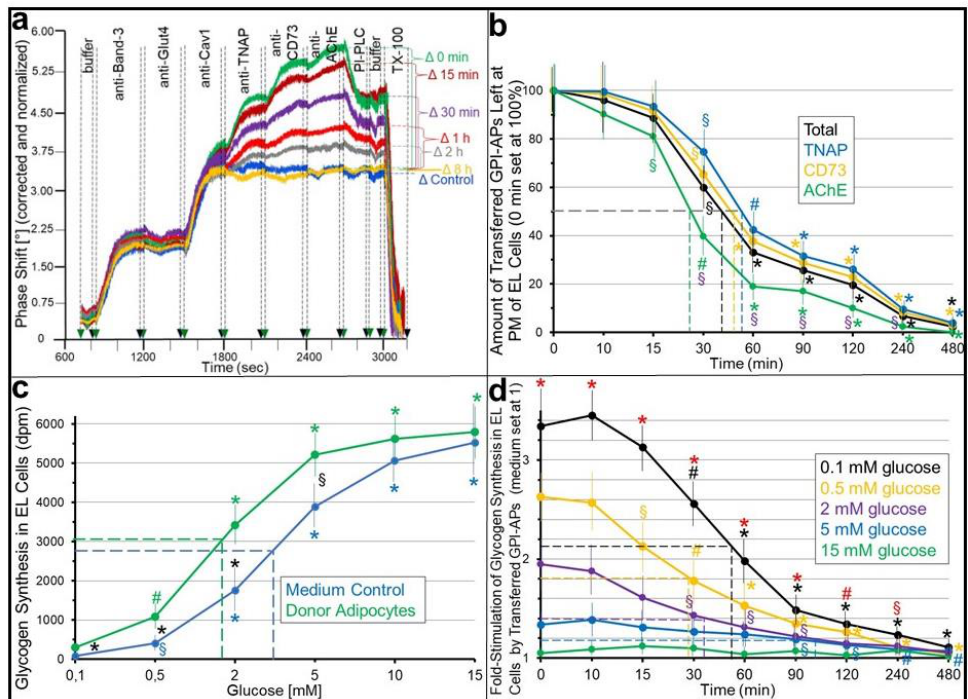
Figure 1. Parallel loss of transferred GPI-APs and of upregulated glycogen synthesis in acceptor ELCs. Transwell co-cultures were run with human adipocytes (of lipid-loading stage IV) as donor cells or only medium (Control) and GPI-deficient ELCs as acceptor cells in the insert and bottom wells, respectively, as described in Section 4. ( a ) After incubation (i) for transfer (1 week, 37 °C, absence of serum and BSA), the insert wells were removed. The bottom wells were rinsed once with medium and then subjected to incubation (ii) with medium for internalization (37 °C, absence of serum and BSA) for the periods indicated (Control for 8 h). Subsequently, PMs were prepared from the ELCs of the bottom wells, then coupled to chips by ionic/covalent capture and, finally, analyzed for the expression of membrane proteins by SAW sensing, as described in Section 4. Phase shifts induced by the sequential binding of antibodies against transmembrane proteins (800 – 1800 s) and then GPI-APs (1800 – 2700 s) and by the subsequent action of bacterial PI-PLC (2700 – 2900 s) and, finally, TX-100 (3000 – 3200 s) are shown, omitting the preceding capturing of the PMs (0 – 700 s; for details as well as methods of correction and normalization, see [29]). Phase shift Δ measured in response to the injection of the anti-TNAP, CD73 and AChE antibodies (1800 – 2700 s) as summation signals, indicated by the horizontal, hatched lines and brackets for each incubation period. ( b ) The experiment was repeated four to six times (distinct incubations for both [i] and [ii]). Relative amounts of total GPI-APs (black line, summation signals corresponding to panel a, 1800 – 2700 s) or individual GPI-APs (colored lines, single signals corresponding to panel a, 1800 – 2100, 2100 – 2400, 2400 – 2700 s) transferred from the adipocytes during the incubation (i) and left at PMs of ELCs after the various periods of incubation (ii) are given. Significant differences between start of internalization (100% GPI-APs left at PMs at 0 min of incubation [i]) and the various periods of second incubation (0 – 480 min) for both total (black symbols) and individual GPI-APs (colored symbols), as well as between total GPI-APs and AChE, for each period of incubation (ii) (turquois symbols) are indicated. ( c , d ) The acceptor ELCs, which were run for 120 min ( c ) or increasing periods ( d ) of incubation, (ii) were used for the determination of glycogen synthesis during incubation (iii) (15 min, 37 °C, presence of BSA) with [U- 14 C]glucose at increasing concentrations and a constant specific radioactivity, as described in Section 4. ( c ) The absolute amount of glycogen synthesized in the ELCs is given (dpm) for the configuration with donor adipocytes or only medium as the control in the insert wells, with significant differences between glucose at 0.1 mM and higher concentrations (green and blue symbols, respectively), as well as between donor adipocytes and medium control, at each glucose concentration (black symbols) indicated. ( d ) The fold-stimulation of glycogen synthesis in ELCs is given for the configuration with donor adipocytes in the insert wells (medium control set at 1) and for each glucose concentration and each period of incubation (ii). Significant differences between 0 min and the various periods of internalization are indicated for each glucose concentration (correspondingly colored symbols), as well as between 0.1 and 15 mM glucose for each period of